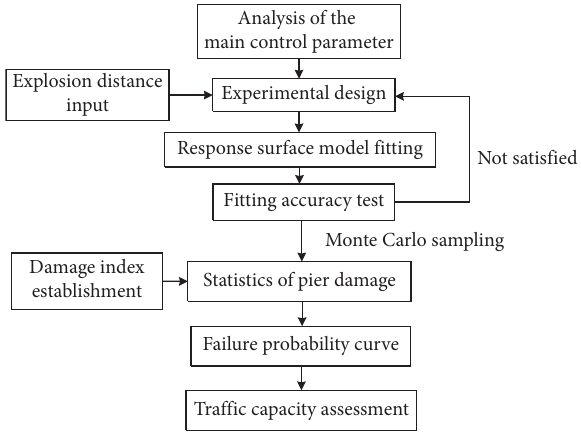
Figure 11: Traffic capacity assessment processes of the urban el- evated bridge after near-field